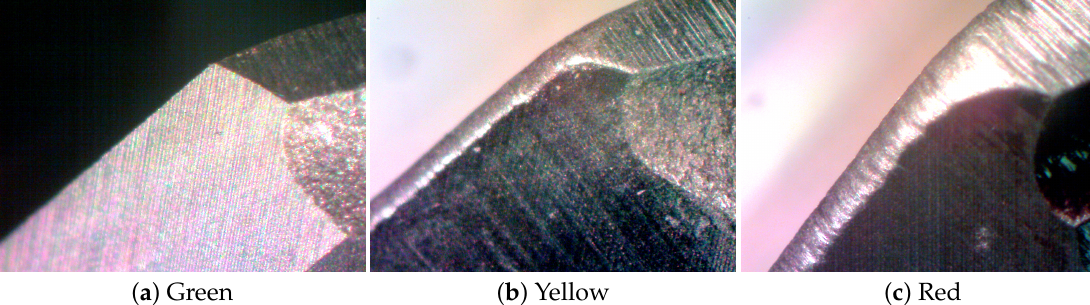
Figure 3. Images showing the wear of the outer drill corner for different classes: Green ( a ), Yellow ( b ) and Red ( c ). The microscope optical magnification equals 30 × , while the total magnification for the monitor was